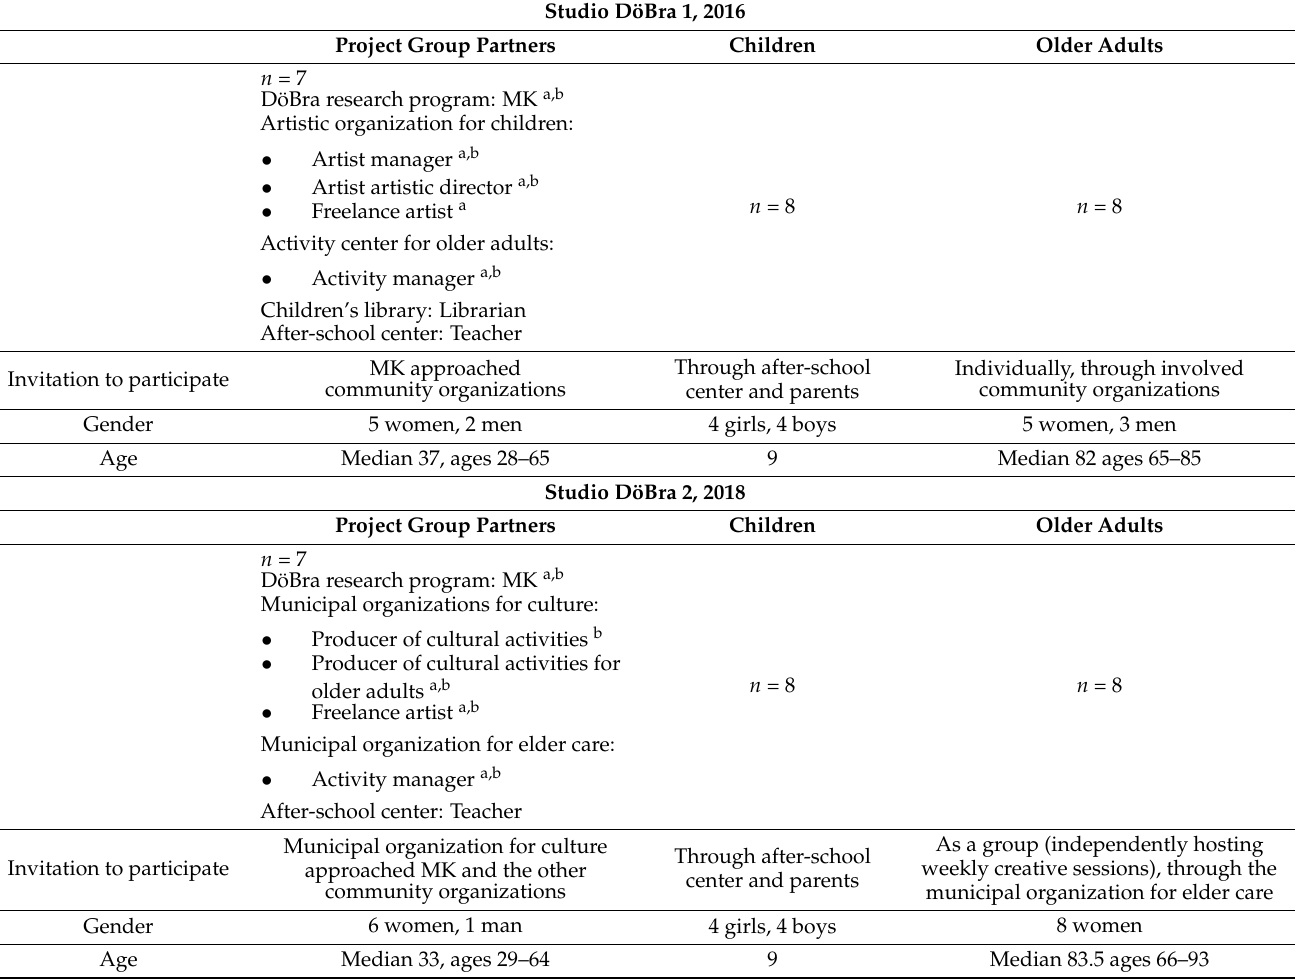
Table 1. Characteristics of the two Studio DöBra iterations and demographic